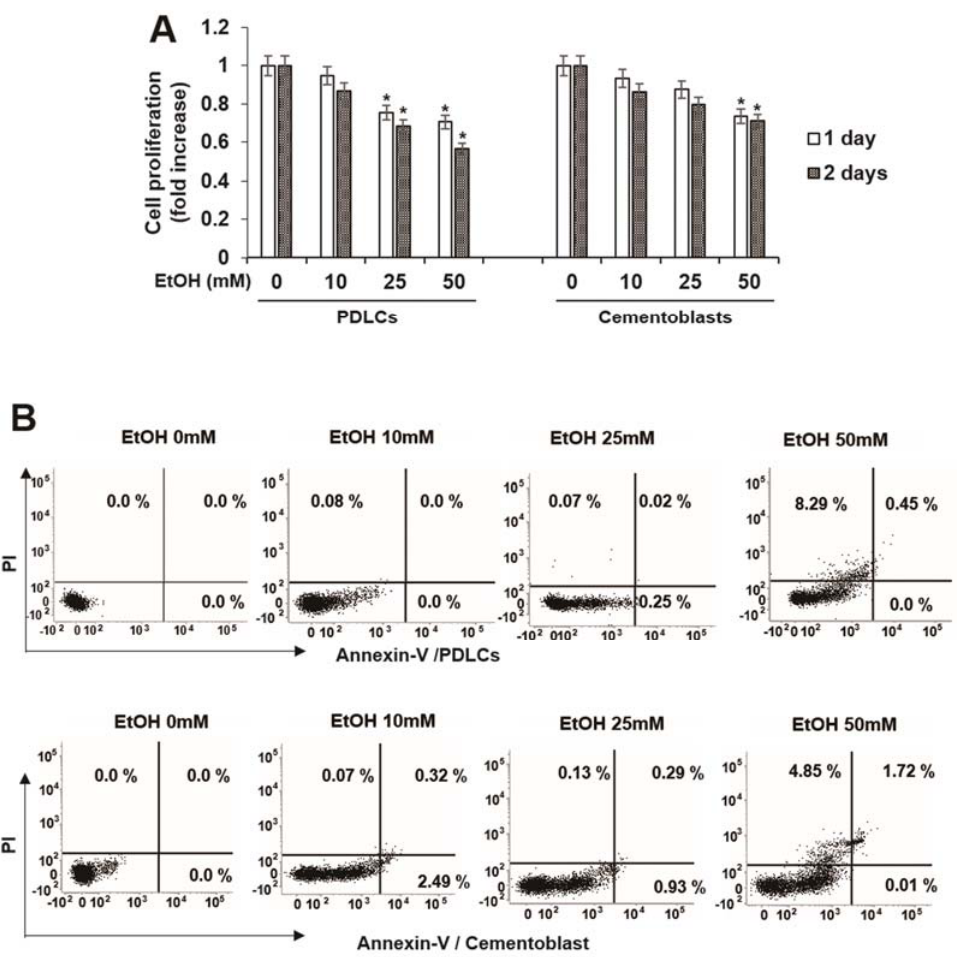
Figure 1. Effect of ethyl alcohol (EtOH) on cell viability ( A ) and cell death in human periodontal ligament cells (HPDLCs) and cementoblast. Cells are incubated with indicated concentration of EtOH for indicated times ( A ) and 3 days ( B ); Cell viability and death were examined by MTT assay and flow cytometry, respectively. These data are representative of three independent experiments. *: statistically significant difference compared to the control groups ( p < 0.05).